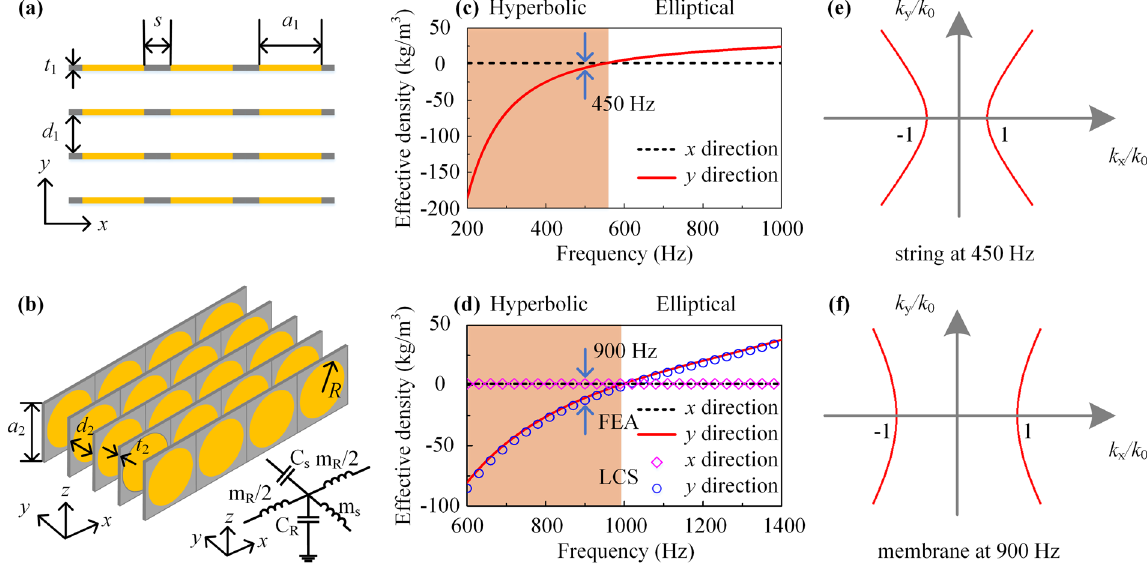
Figure 2. Designs of (a) the string-type and (b) the membrane-type AHMM. Retrieved effective mass density along the x and y directions of the (c) string-type and (d) membrane-type AHMM. The orange region ρ ρ ⋅ < ). The EFC of (e) the string-type corresponds to the frequency range of the hyperbolic dispersion ( 0 x y AHMM at 450 Hz and (f) membrane-type AHMM at 900